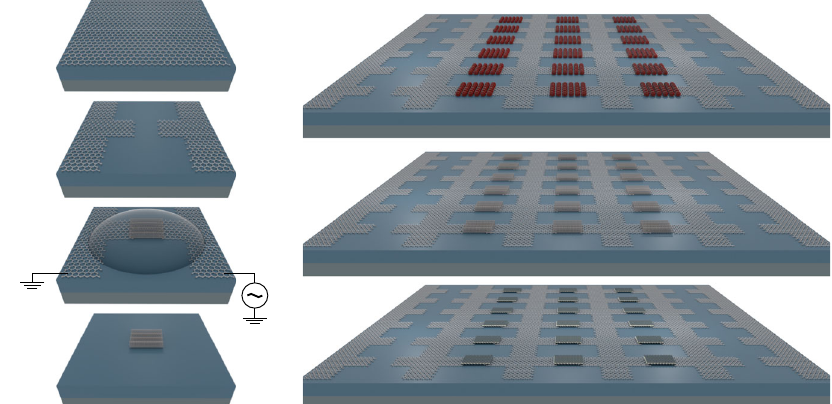
Fig. 1 Electric- fi eld-assisted placement of nanomaterial from solutions with patterned graphene. Artistic rendering of electric- fi eld-assisted placement of nanoscale materials between pairs of opposing graphene electrodes structured into a large graphene layer located on top of a solid substrate. The sketches on the left-hand side visualize the key steps of the method: structuring a large-scale graphene layer to form local electrodes, applying a AC voltage for facilitating the fi eld-assisted placement of nanomaterials from solution (shown are carbon nanotubes), and removing the graphene structure once the placement is complete. In the visualization on the right-hand side, quantum dots (0D), single-walled carbon nanotubes (1D), and layers of molybdenum disul fi de (2D) are shown as representative nanomaterials that can be assembled at large scale based on the graphene-based, electric- fi